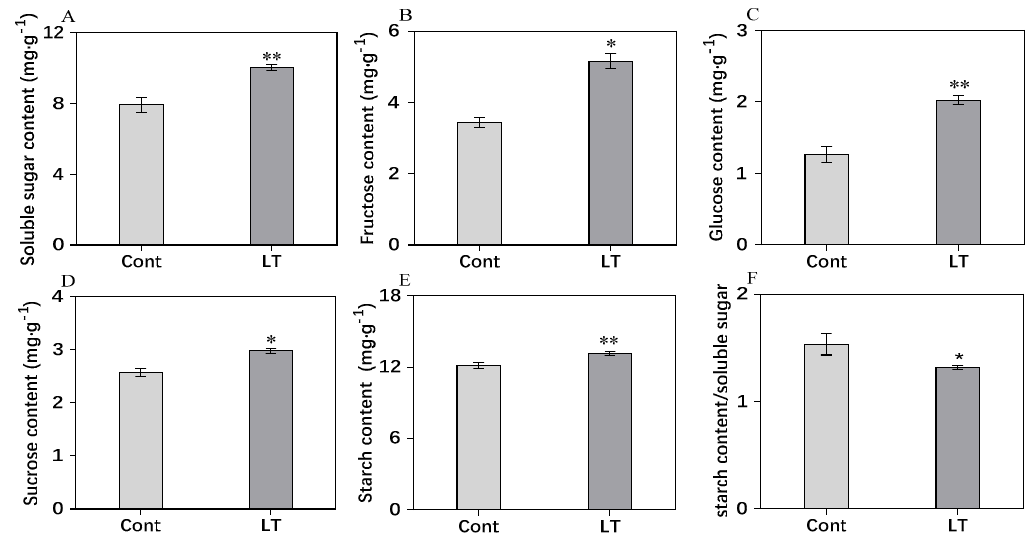
Figure 5. Carbohydrate contents and starch/soluble sugar ratio under low temperature and control conditions in wucai leaves. The amounts of Soluble sugar ( A ), Fructose ( B ), Glucose ( C ), Sucrose ( D ), Starch ( E ) and Starch content/soluble sugar ( F ) are shown. * represents significant at P < 0.05 , ** represents significant at P < 0.01 .